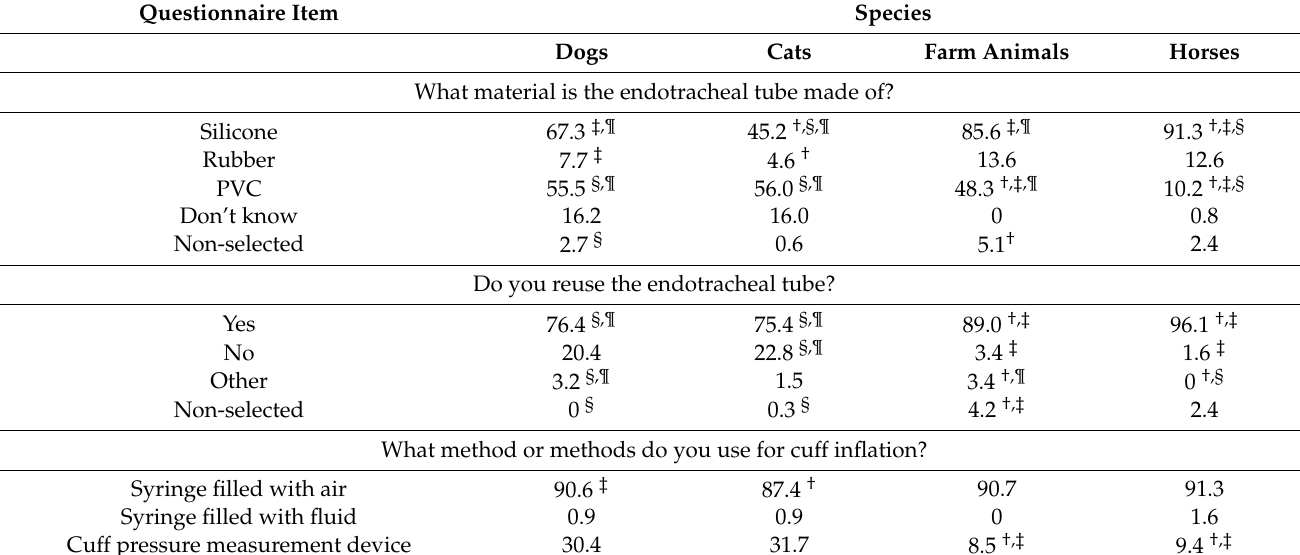
Table 1. Response frequency table (percentage of total number of responses) for each species category and statistical significance per questionnaire item between species. Note: For some questionnaire items, study participants could select multiple options; therefore, the total is